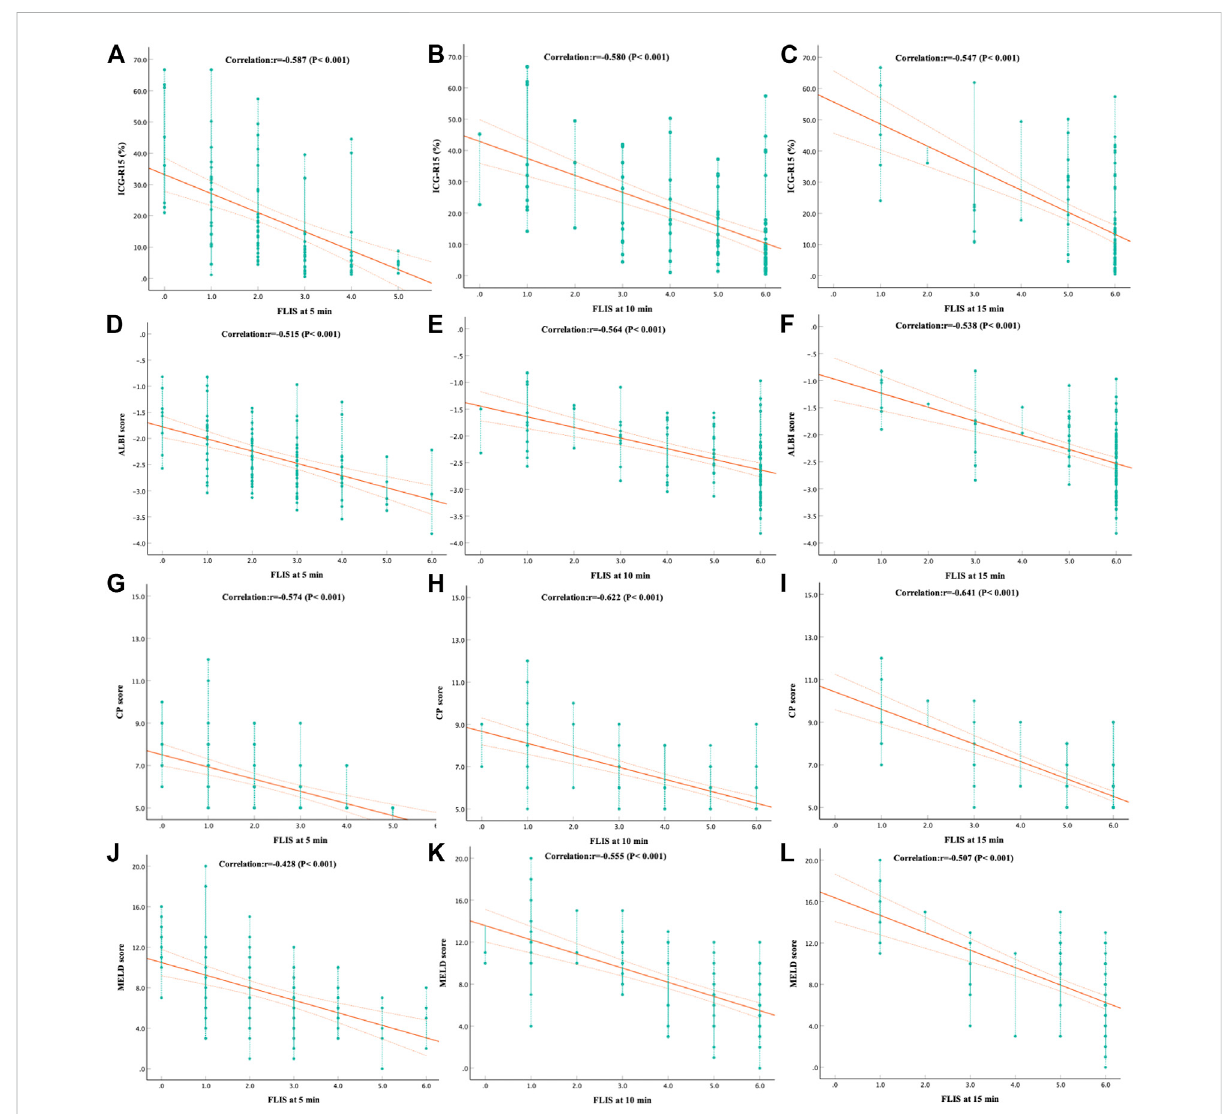
FIGURE 3 The correlation between (A – C) ICG-R 15 , (D – F) ALBI score, (G – I) CP score and (J – L) MELD score and FLIS at different time points. The correlation was assessed by using the Spearman rank correlation analysis. In addiiton, FLIS, functional liver imaging score; ICG-R 15 ,